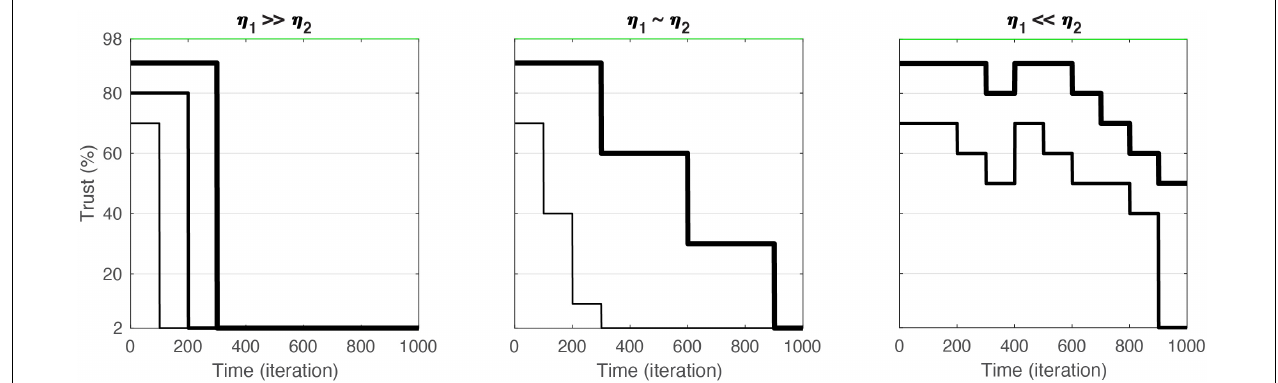
FIGURE 2 | Illustration of three scenarions depicting ratios of η 1 / η 2 in the PG game. While the three conditions show different styles of operation, “realistic” (left) , “reciprocal” (middle) , and “lovers” (right) , all scenarios typically ultimately converge to a state of complete distrust. This is because of the disproportional opportunity for η 1 (decrease in trust) to occur compared to η 2 (increase in trust). The initial trust ( iT ) simply determines the speed of decay. Lower values of iT lead to faster convergence to distrust. Lines illustrate different trust trajectories across games.